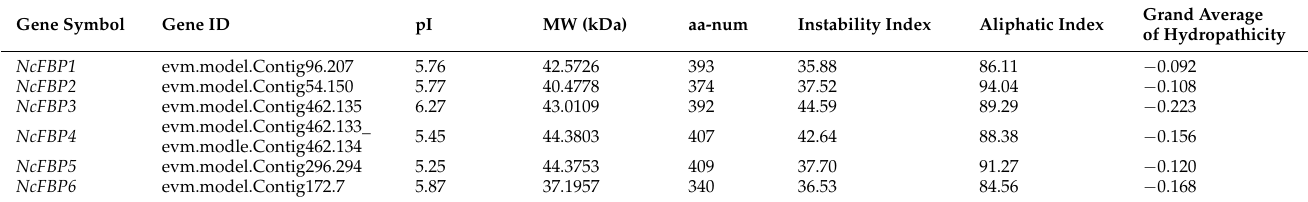
Table 2. Physicochemical properties of FBP protein in N. cadamba